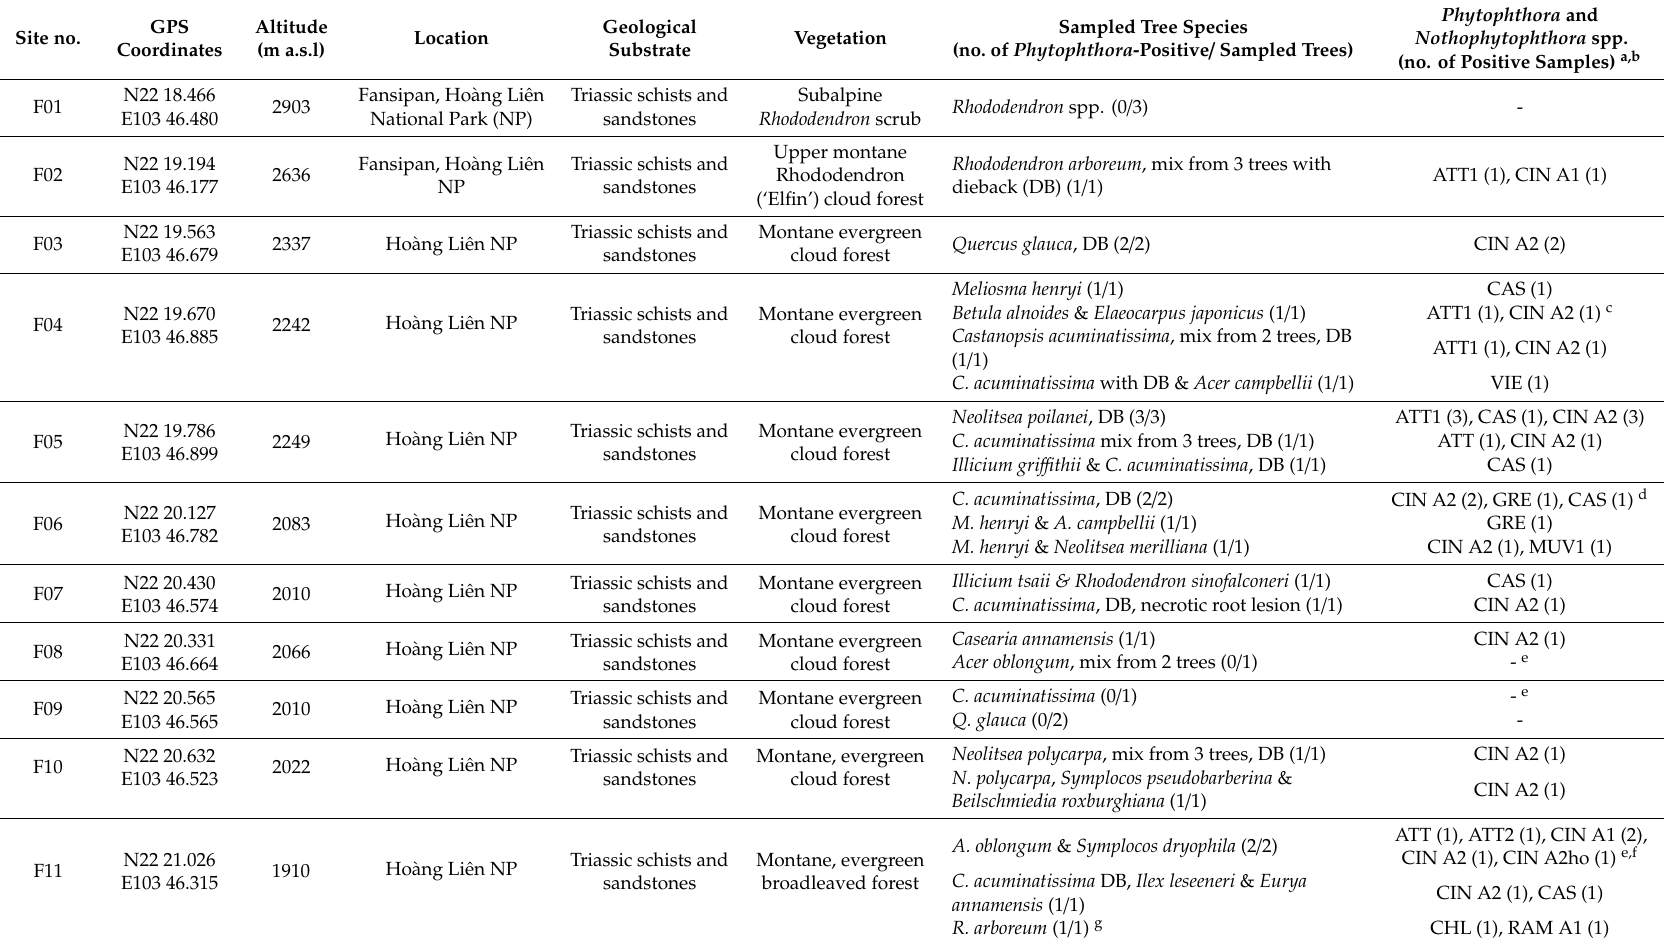
Table 1. Location, altitude, geological substrate and vegetation of 25 forest sites sampled in spring 2016 and 2017 in Vietnam, sampled tree species and Phytophthora and other oomycete taxa